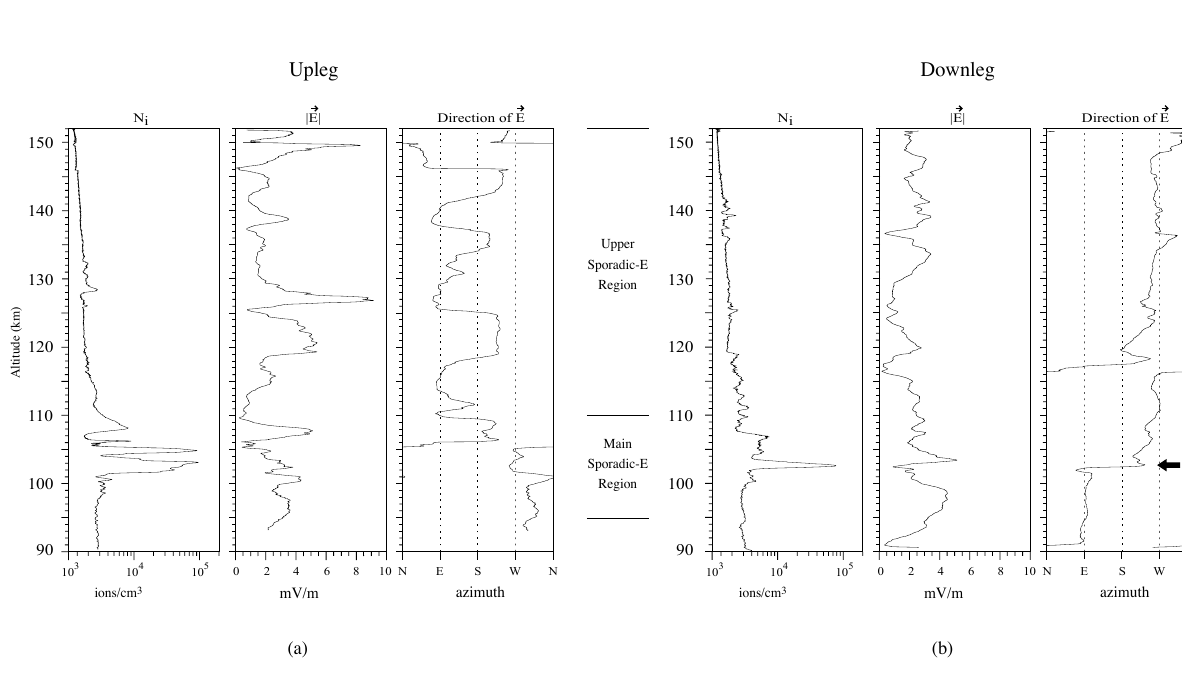
Fig. 8. Electric field and plasma density displayed versus altitude for the upleg (a) and downleg (b) .